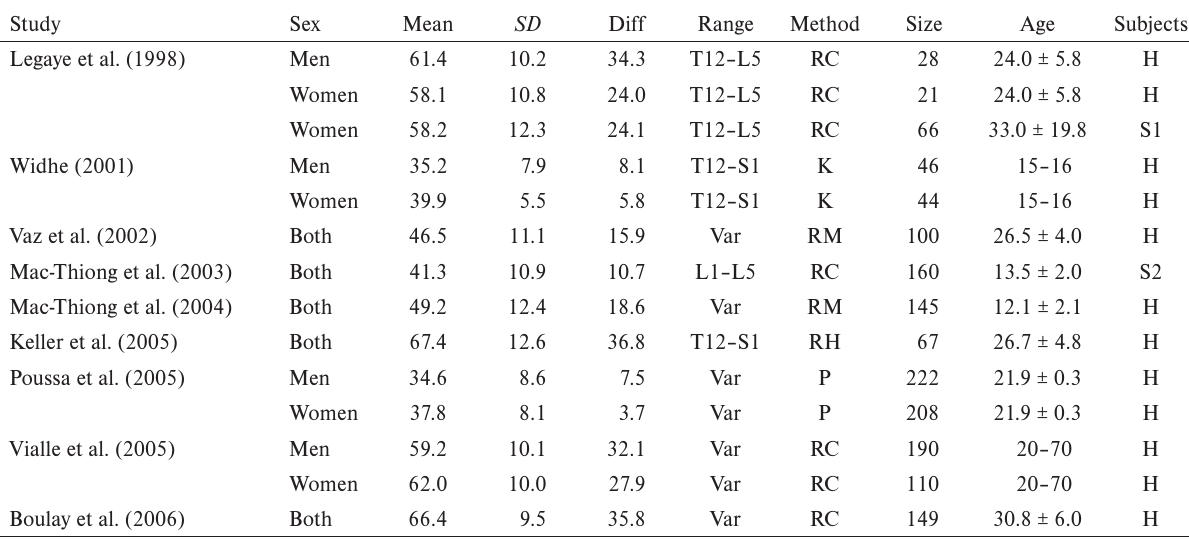
Note. Studies are sorted by the year of publication. Diff = difference between the study and this study (this study revealed the value of 27.1° for men, the value 34.1° for women and we used the mean value of 30.6° for both sexes); Range = range of vertebrae considered as a lumbar lordosis (Var means individual range for each subject); Age = values are shown in format Mean ± SD or Min–Max; RC = radi- ography and Cobb method; RH = radiography and Harrison tangent method; RM = radiography and a geometric model; K = Debrunner kyphometer (non-radiographic); P = Spinal pantograph (non-radiographic); H = healthy; S1 = scoliotic (Cobb angle 42.4 ± 25.3°); S2 = scoliotic (Cobb angle